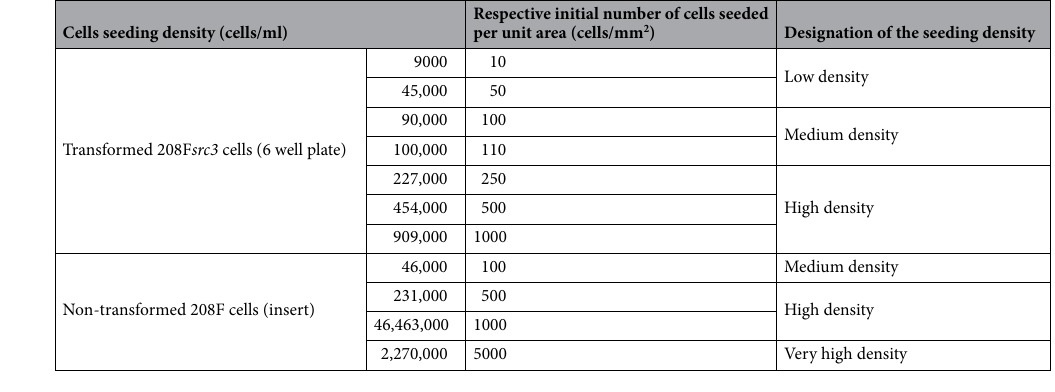
Table 1. Transformed and non-transformed cells seeding